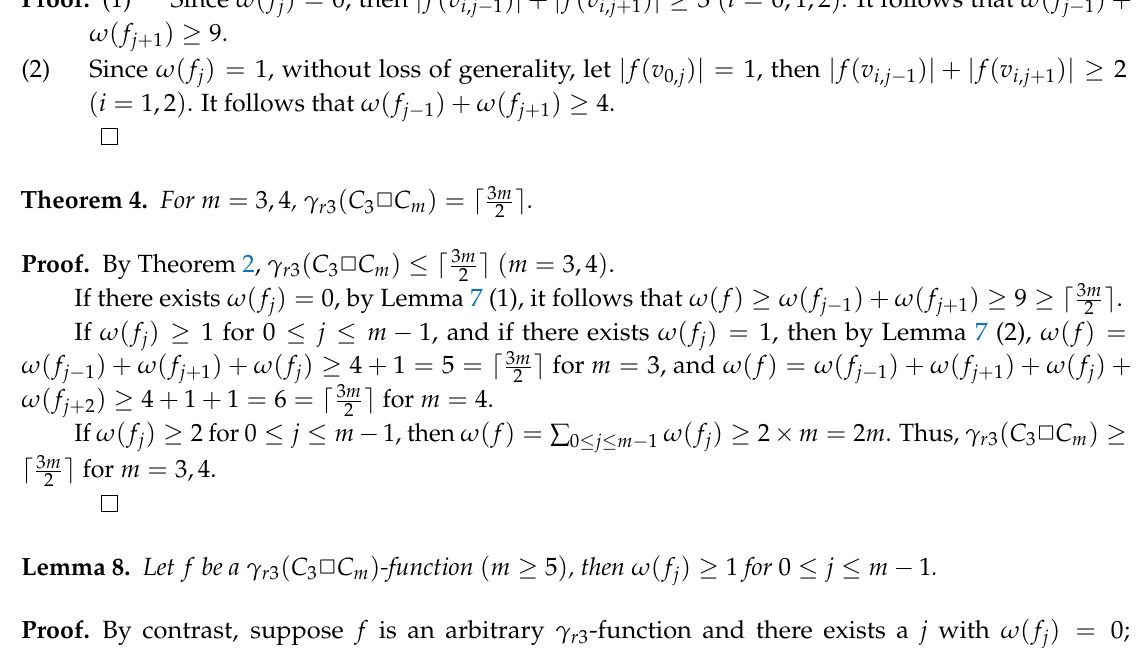
Figure 10. f on C 15 2 C 14